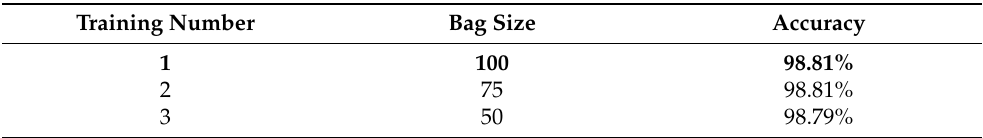
Table 5. RF algorithm hyperparameter optimization results using 100 as the number iterations or the trees in the forest, and a maximum depth of zero, which means unlimited